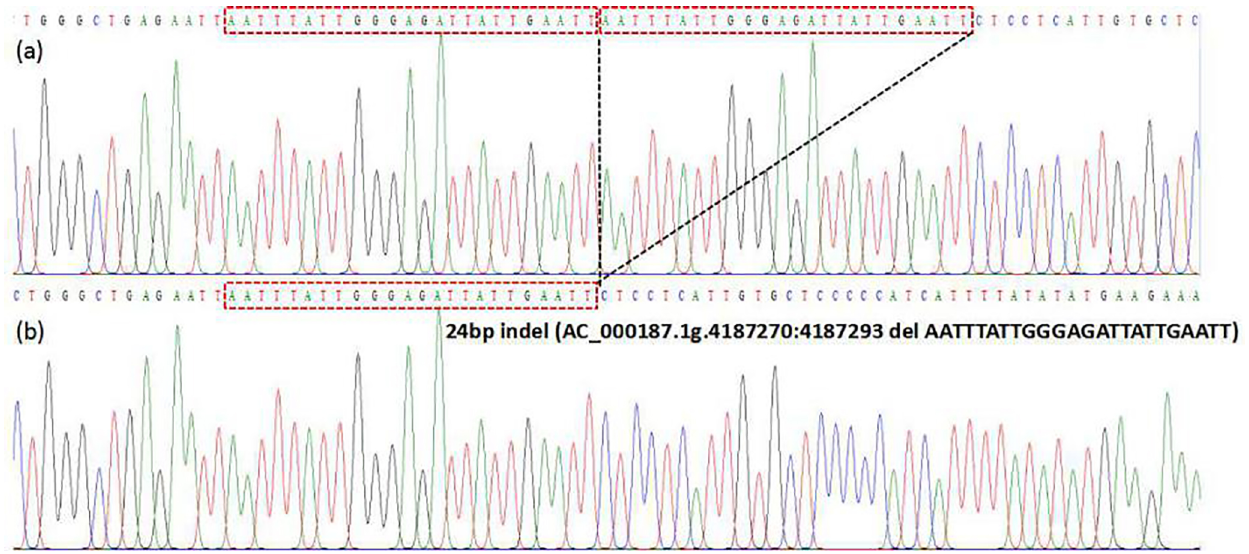
Figure 2. Sequencing maps for the 24bp indel in the cattle AR gene. Panel (a) : homozygotic insertion type (II); panel (b) : homozygotic deletion type (DD). The sequence with the red border is the 24bp deletion. Table 2. Genotypes, alleles, He, Ne, and PIC for the novel indel of the cattle AR gene. Breeds Sizes Genotypic frequencies Allelic frequencies HWE Population parameters N II ID DD I D P values Ho He Ne PIC LX 113 29 40 44 0.434 0.564 P <0.05 0.509 0.491 1.965 0.371 QC 227 133 68 26 0.736 0.264 P <0.05 0.611 0.388 1.636 0.313 NY 134 13 79 42 0.489 0.511 P <0.05 0.523 0.477 1.911 0.670 JX 140 49 71 20 0.604 0.396 P >0.05 0.521 0.479 1.918